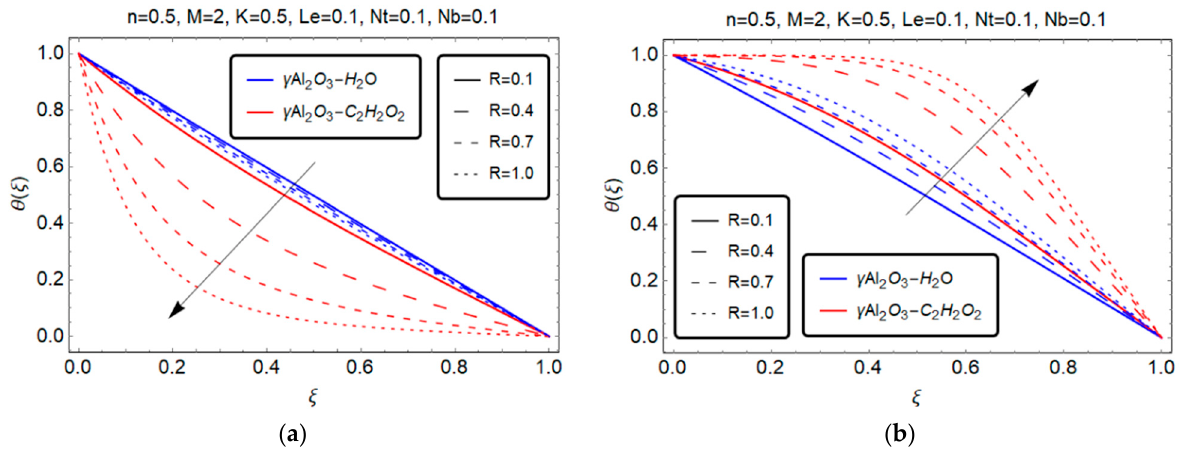
Figure 8. Effect of squeezed Reynold number R on 𝜃(𝜉) . ( a ) S > 0; ( b ) S < 0.